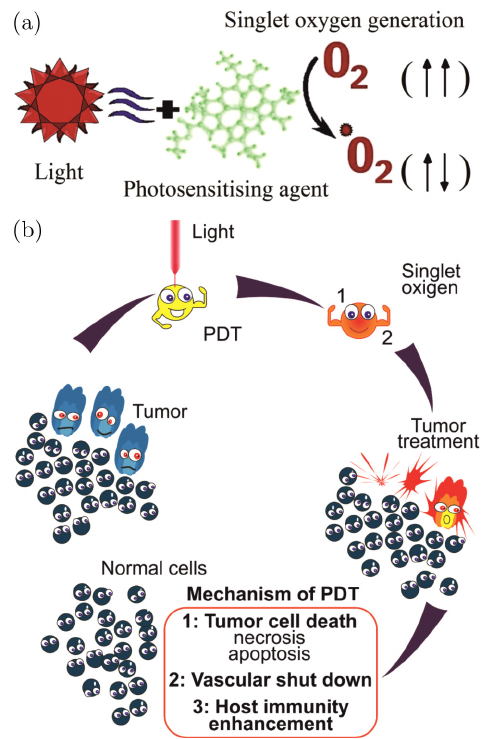
2016.Fig. 1. Mechanisms of singlet oxygen generation (a) and PDT-mediated damage of tumor cells (b).